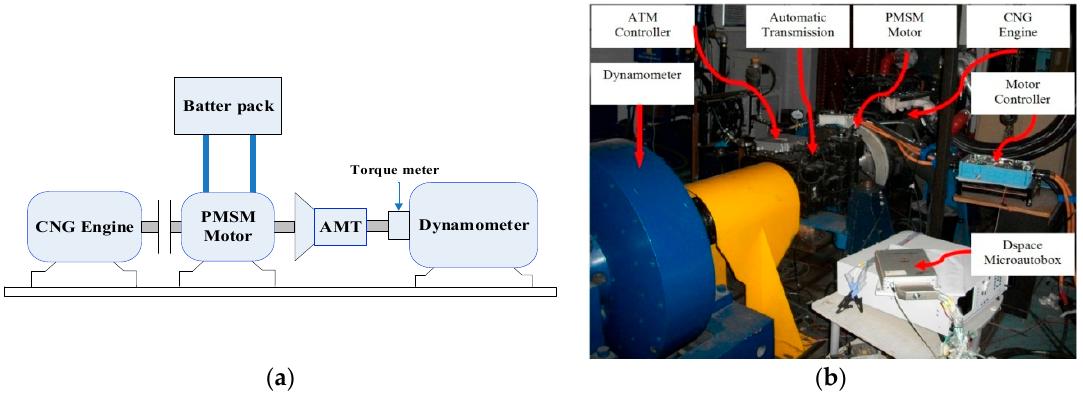
Figure 10. Layout and physical map of test bench. ( a ) experimental platform diagram; ( b ) experimental platform photo.